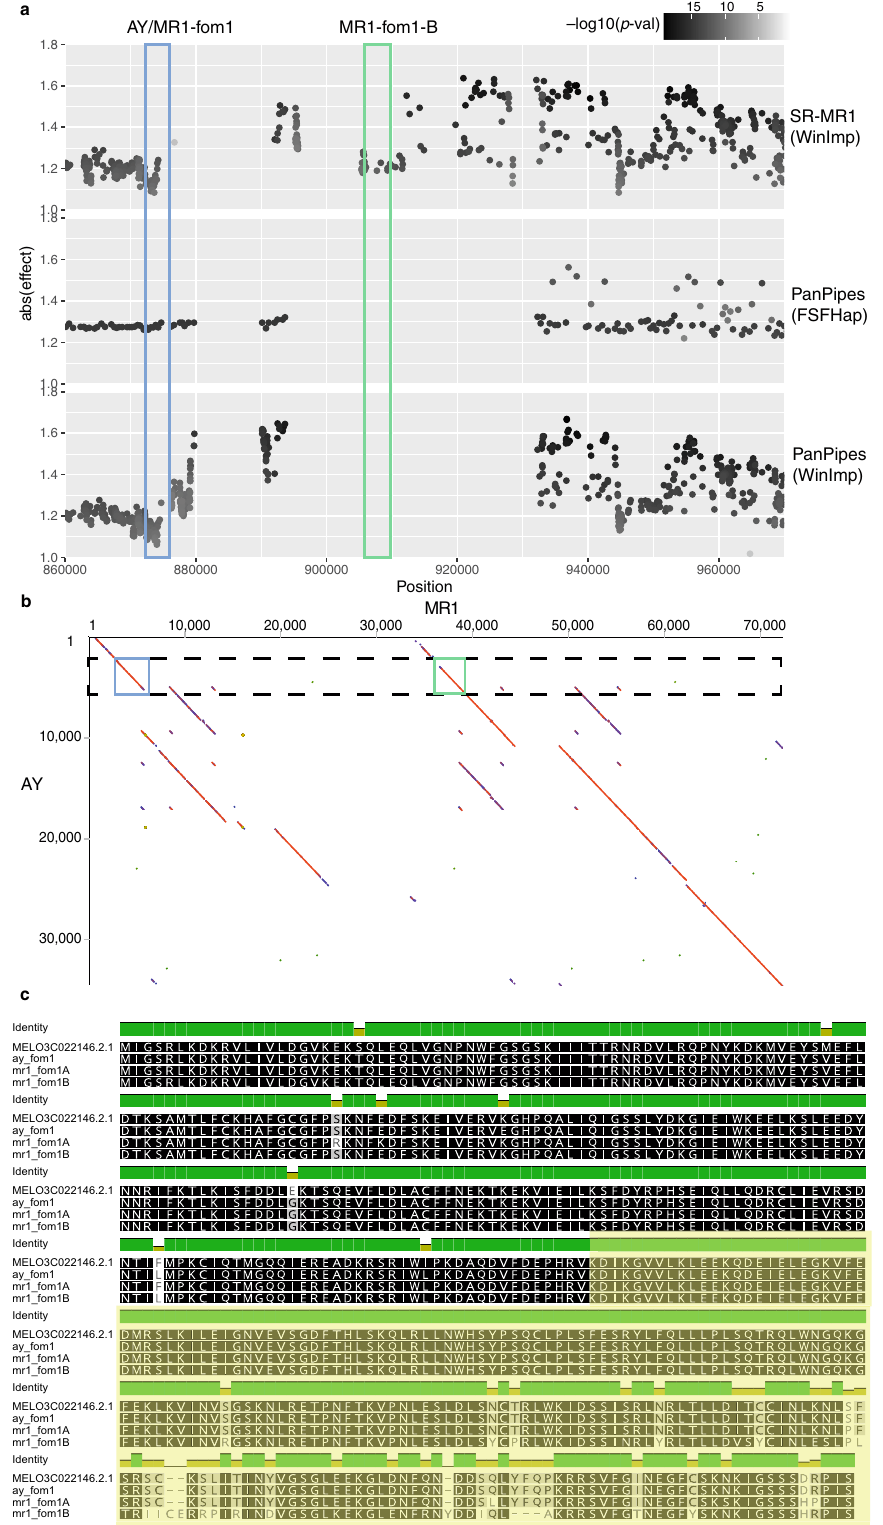
Fig. 6 | Substantial tandem duplication of the fom1 locus on Chr 09. a Association pro fi les across variousgenotyping/imputationmethods described in main text. Estimated effects are depicted on y -axis and darkness of dot indicates p value (see “ Methods ” ). Blue box highlights the known fom1 NBS-LRR while green box de fi nes paralog position identi fi ed from thisstudy. b Dotplot between AY and MR1(originattopleft)shows substantialduplicationoflarge NBS-LRRcontatining